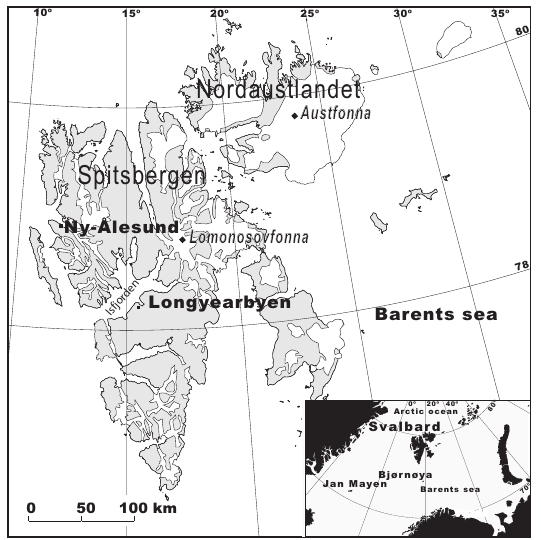
Fig. 1. Map of the Svalbard archipelago including names of islands (Large font), locations discussed in this study (bold) and major ice caps